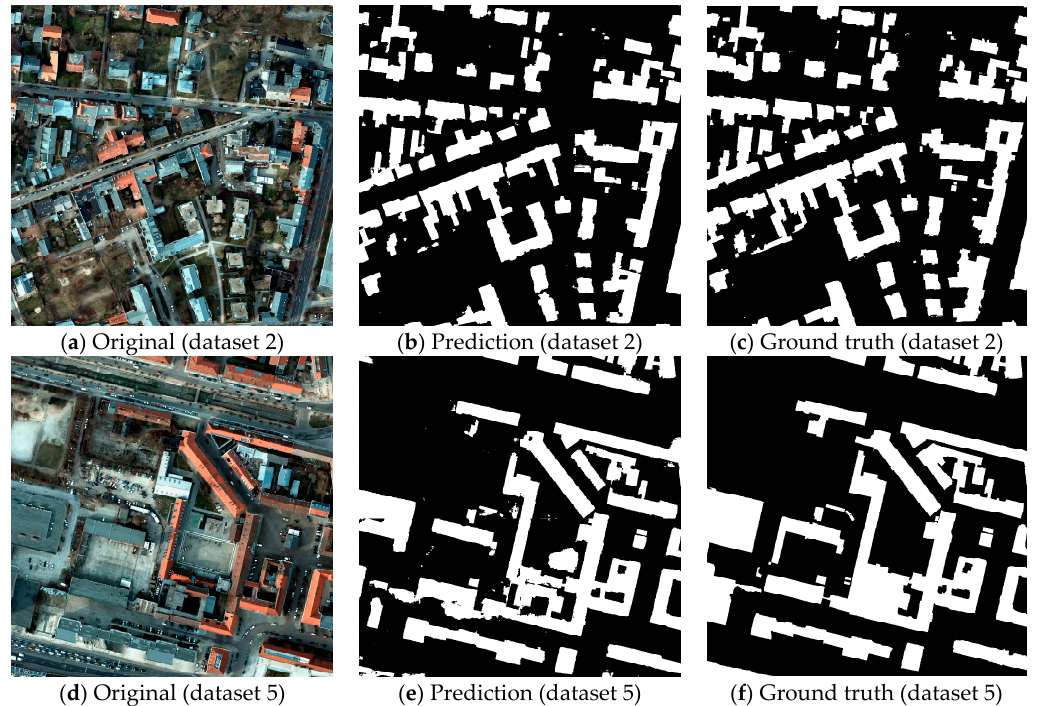
Figure 5. The worst results and the best results of the building extraction using the DAN. ( a ) represents the original RGB image of dataset 2; ( b ) represents the corresponding prediction from deep learning; ( c ) represents the corresponding ground truth. ( d – f ) are the original RGB image of dataset 5, prediction from deep learning, and the corresponding ground truth, respectively.